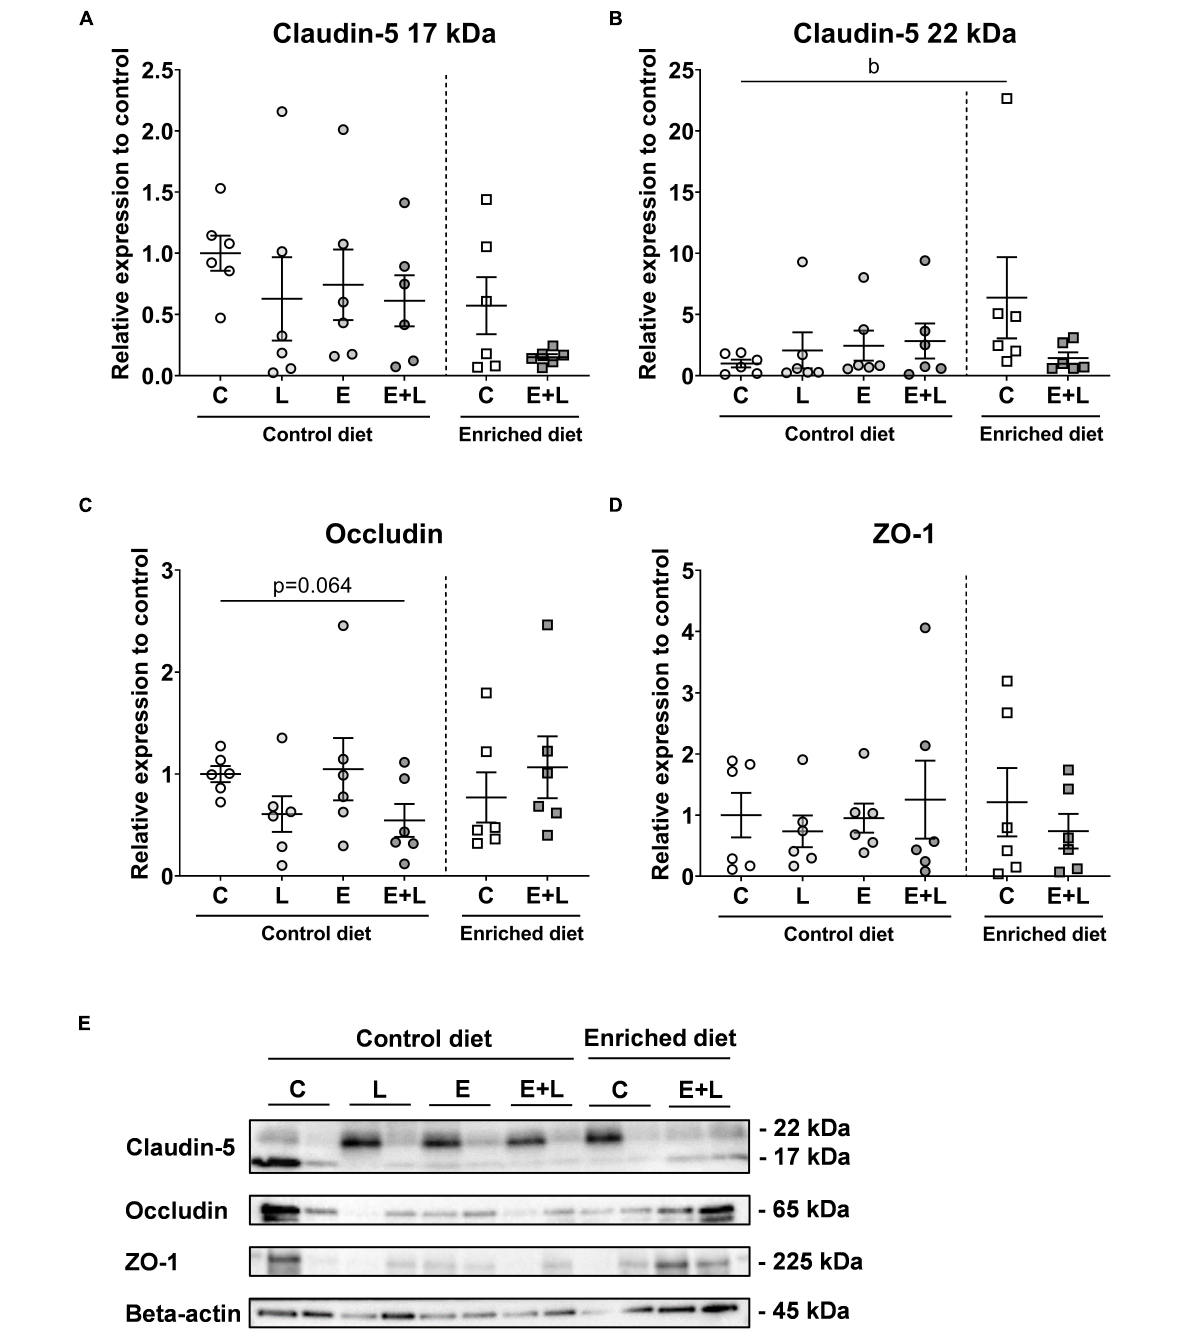
FIGURE9 Tight junction expression levels in isolated brain microvessels after sacrifice at day 58. Expression levels of the 17 kDa (A) and 22 kDa (B) , claudin-5, occludin (C) , and ZO-1 (D) were quantified. Beta-actin normalized levels were compared to controls. Representative blots are presented in panel (E) . b p < 0.05 (second analysis for diet and/or E + L effects). Data are expressed as mean ± SEM ( n = 6 per group). C, control; L, LPS; E, elastase; E + L, elastase plus LPS.